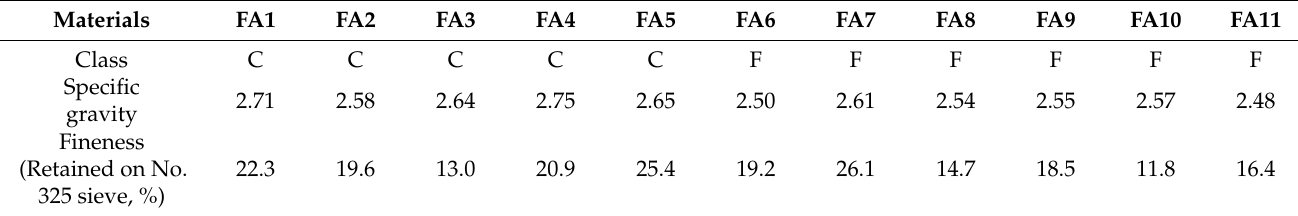
Table 2. Classification and physical properties of fly